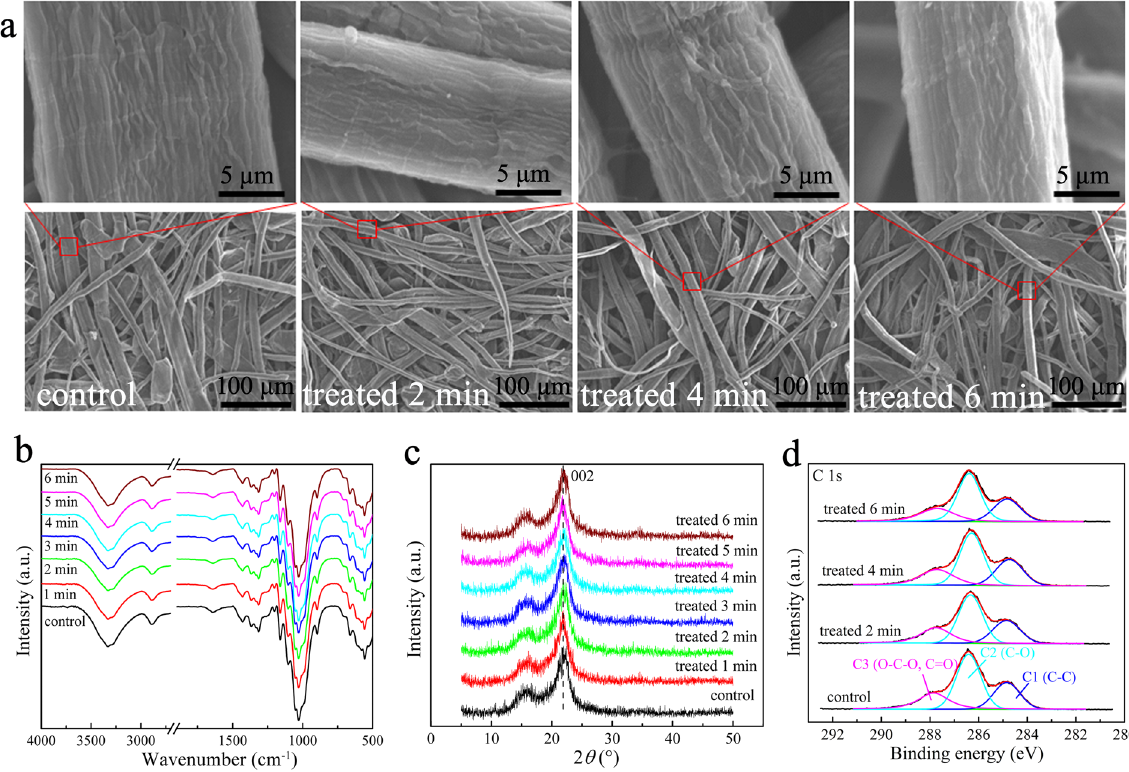
Figure 8. SEM images ( a ), FT-IR spectra ( b ), XRD patterns ( c ) and C 1 s XPS spectra ( d ) for the control paper and the paper treated by HPEC with different